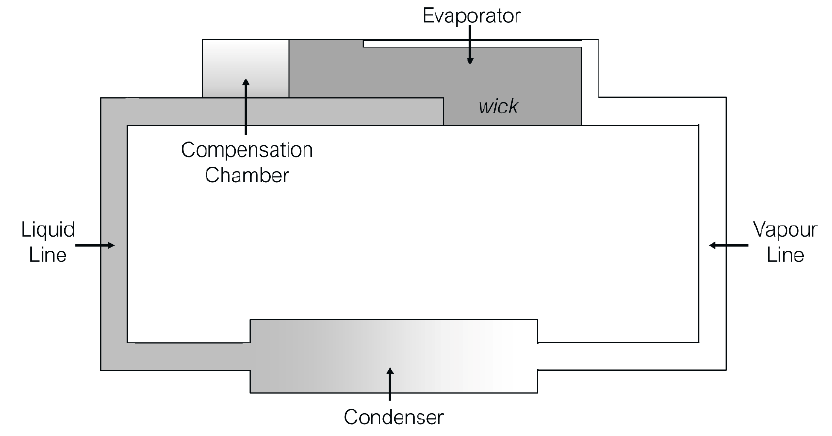
Figure 1. Loop Heat Pipe with flat plate evaporator schematic.